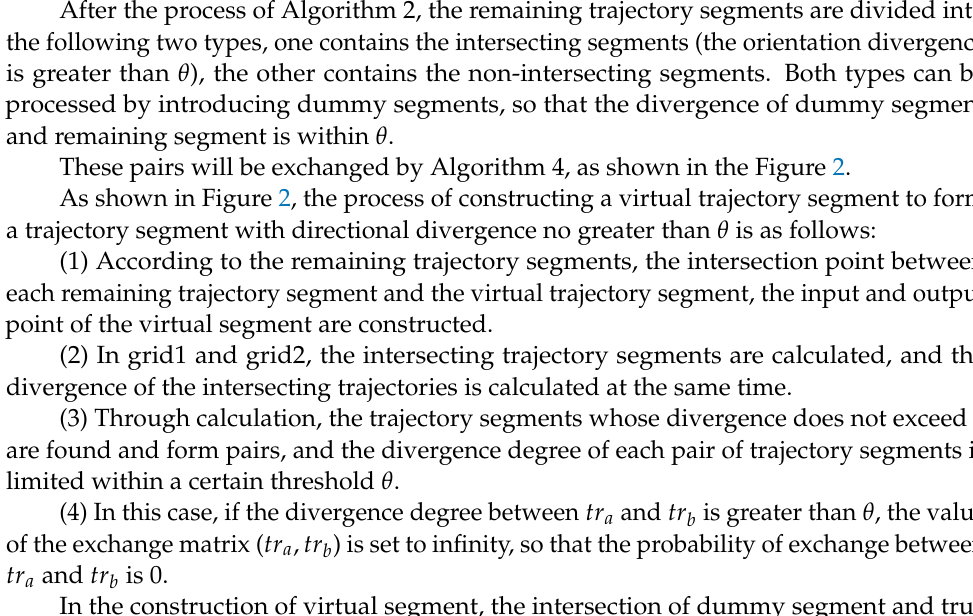
Algorithm 3 solves the problem of the remaining trajectory